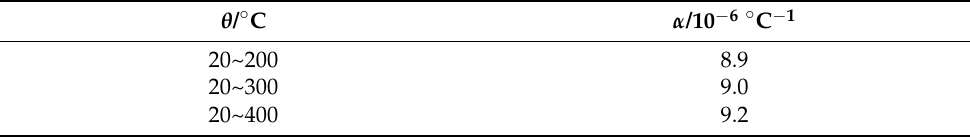
Table 2. The coefficient of thermal expansion